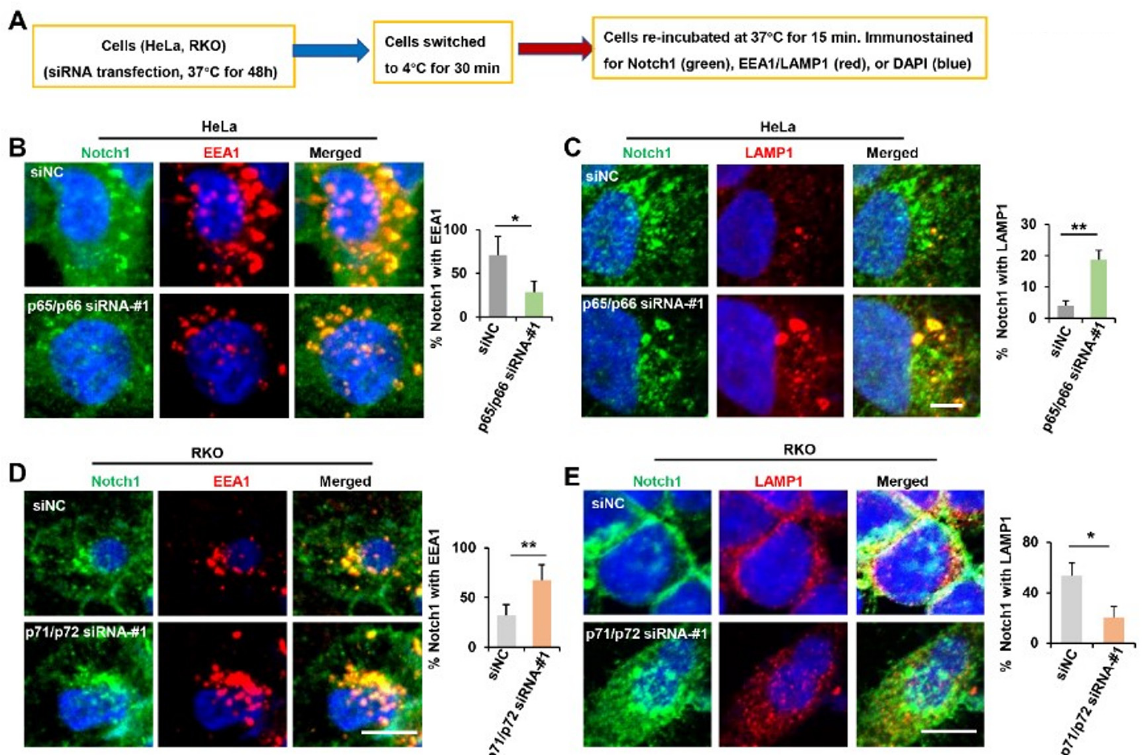
Figure 6. NUMB isoforms distinctly influence the post-endocytic trafficking of Notch1. ( A ) Diagram of cell treatment before immunostaining. ( B , C ) HeLa were treated with siNC and p65/p66 siRNA-#1, as described in ( A ), and stained with Notch1 (green), EEA1 (red) or LAMP1 (red). Representative confocal images were shown. Scale bar is 10 µ m. Percentage of Notch1 colocalized with EEA1 or with LAMP1among the total amount of Notch1 is shown as mean ± SD in the right panel. ( D , E ) RKO cells were treated with siNC and p71/p72 siRNA-#1, as described in ( A ), and stained with Notch1 (green), EEA1 (red) or LAMP1 (red). Representative confocal images are shown. Scale bar is 10 µ m. Percentage of Notch1 colocalized with EEA1 or with LAMP1 with the total amount of Notch1 is shown as mean ± SD on the right panel. * p < 0.05, ** p <